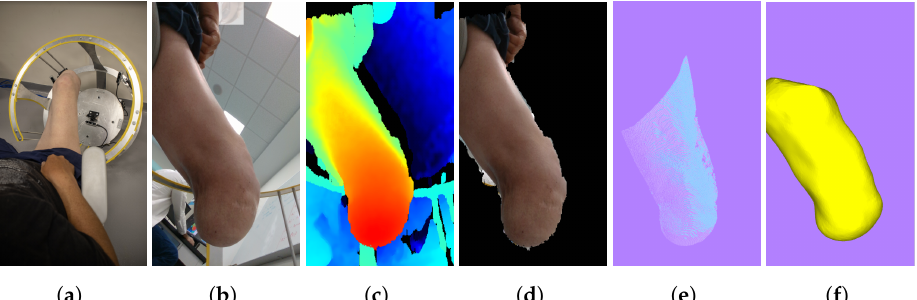
Figure 15. Testing of the system with a participant, starting from ( a ) the general view of the system and the participant, ( b ) the color image from one of the cameras, ( c ) the aligned depth image, ( d ) the segment of the target, ( e ) the mapping of the PC and ( f ) the resulting surface mesh after the 5 images reconstruction. This shows the process from start to finish of the system viewed from one camera